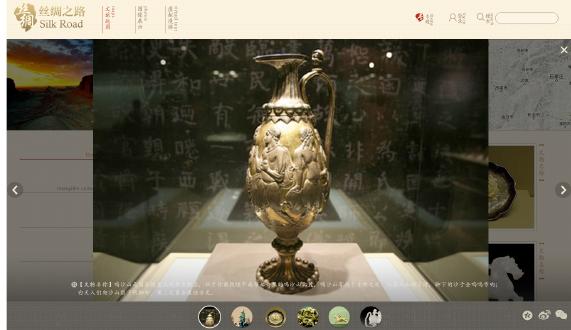
Figure 7: Example of detailed information about cultural relic under “topic” of the website